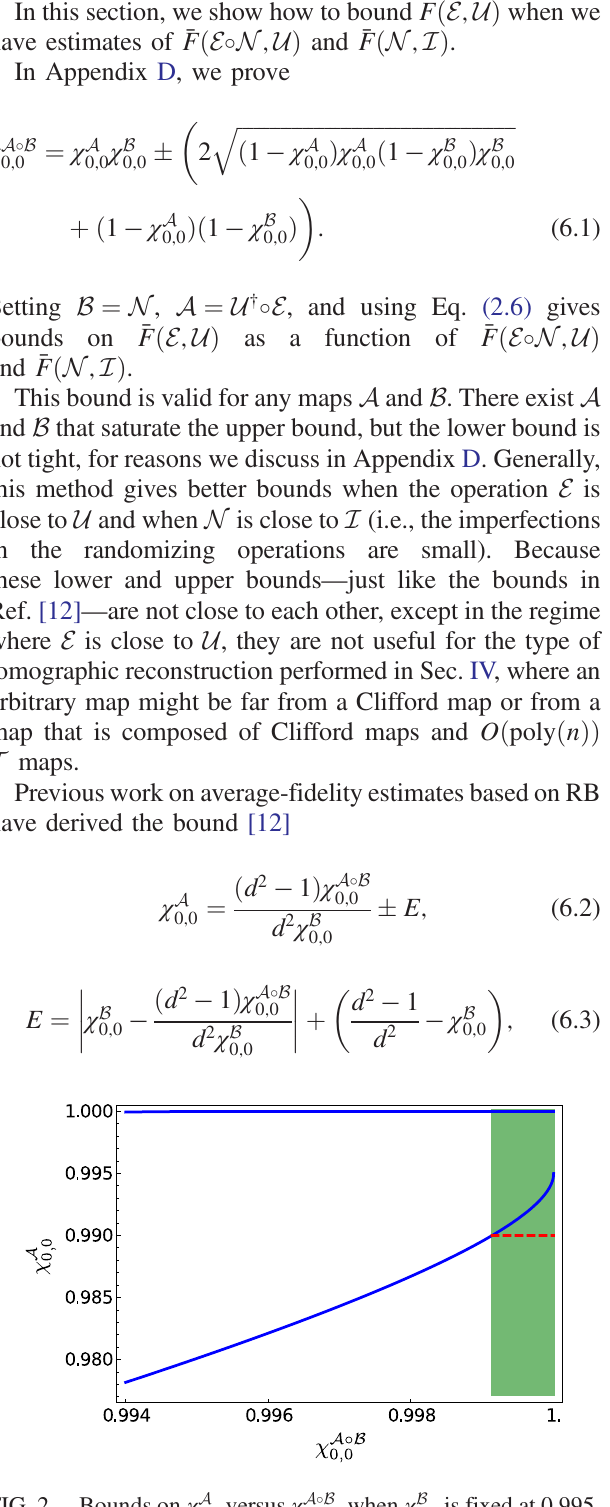
FIG. 2. Bounds on χ A 0 ; 0 versus χ A ∘ B 0 ; 0 , when χ B 0 ; 0 is fixed at 0.995. Our bounds are shown as a solid blue line, while the bounds of Ref. [12] are shown as a red dashed line. The bounds of Ref. [12] are valid in the green shaded region, while our bounds are valid for all values of χ A ∘ B 0 ; 0